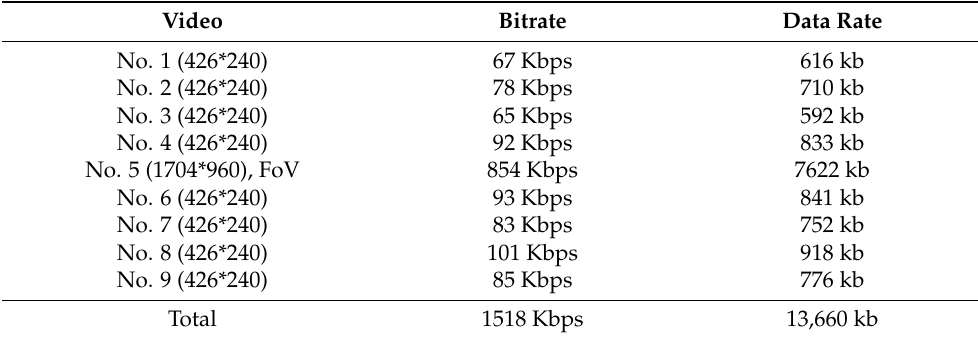
Table 5. Bitrate and size comparison for each game streaming video.